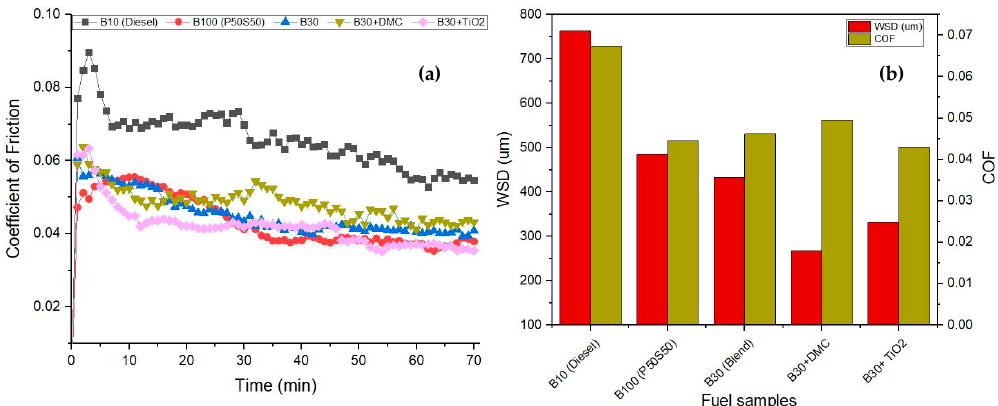
Figure 7. Coefficient of friction ( a )(COF) and ( b )wear scar diameter (WSD) trend for all tested fuel samples.